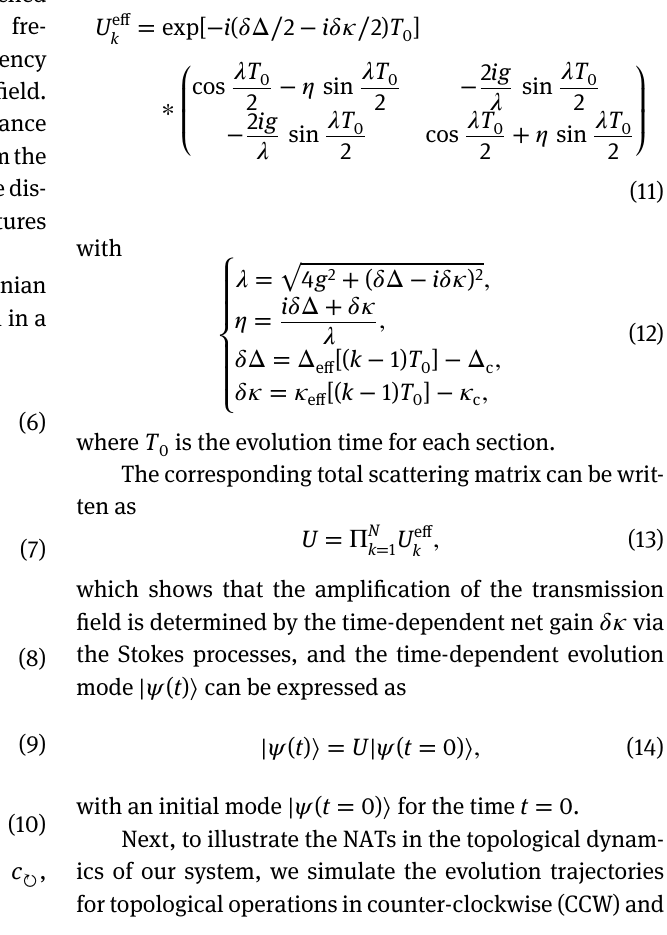
= 140mW) Figure1(c).Twoindependentorangecircles( P d = 151 mW) are gradually melting into a big green circle ( P d with the increase of the pump power P . It is the larger d pump power P that provides a larger effective gain and d ensures the EP to be enclosed in closed circles. In addi- tion, topological features can also be identified from the Riemann surface in Figure